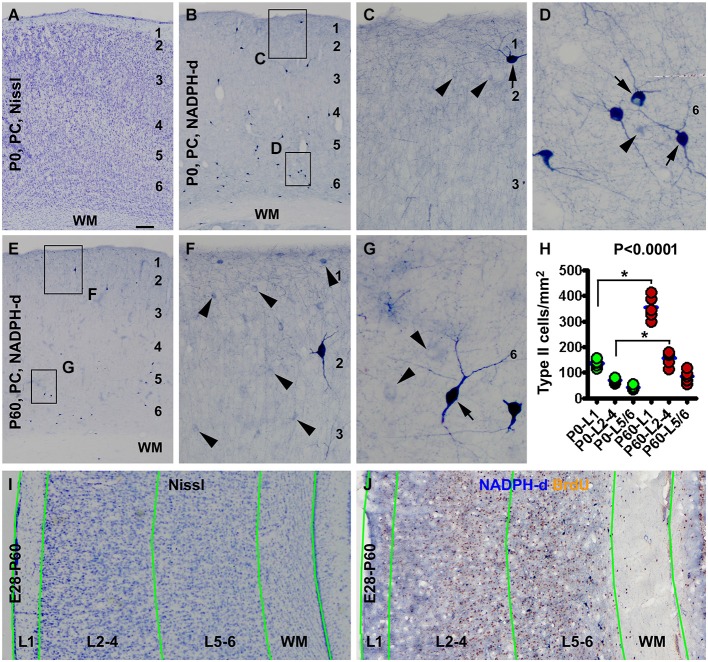
Laminar architecture, nicotinamide adenine dinucleotide phosphate-diaphorase (NADPH-d) positive neurons in the neocortex of neonatal and 2 month-old (postnatal day 60, P60) guinea pigs, and methodological illustration for lamina-based cell count. Panel (A) shows a Nissl stain image of the parietal neocortex (PC) around the border of the primary motor (left portion) and somatosensory (right portion) cortex from a newborn (P0). Layers 1 to 6 are identifiable above the white matter (WM). Panel (B) is a low magnification image of NADPH-d neurons in the somatosensory cortex of a newborn, with the framed areas enlarged as (C) and (D). Panel (E) is a low power view of NADPH-d reactivity in the somatosensory cortex in a P60 animal, with the framed areas enlarged as (F) and (G). Examples of type I and type II NADPH-d neurons are pointed by arrows and arrowheads, respectively. The densities of type II NADPH-d neurons in layer 1 (L1), layers 2–4 (L2-4) and layers 5 and 6 (L5/6) in the parietotemporal neocortex are increased in the P60 (n = 5) relative to P0 (n = 5) groups (calculated based on the cell count data obtained from NADPH-d/BrdU dual staining preparations) (H). For counting NADPH-d positive and NADPH-d/BrdU colabeled neurons, the sampled parietal and temporal cortical regions are divided into L1, L2-4, L5/6 and white matter (WM). Borders of the laminar sectors are created in the montaged Nissl stain image of an adjacent section (I), which were copied as a template and then pasted on the montaged dual staining image (J). The size of the template is adjusted proportionally by aligning the pial and ventricular lines as closely as possible. NADPH-d neurons in each laminar sector are classified and counted on screen at high resolution. Scale bar = 100 μm in (A) applying to (B,E), equivalent to 50 μm for (I,J), 20 μm for (C,F) and 10 μm for (D,G).